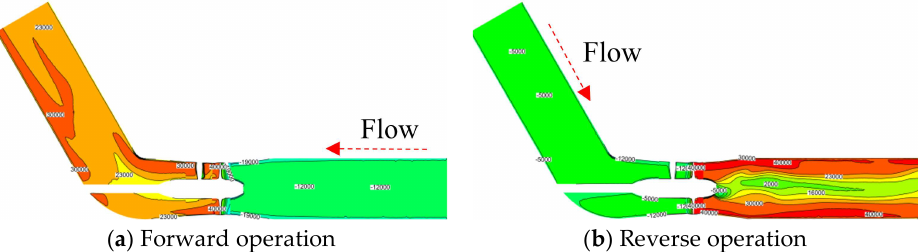
Figure 14. 1.0 Q d clouds of total pressure distribution in the middle cross section.